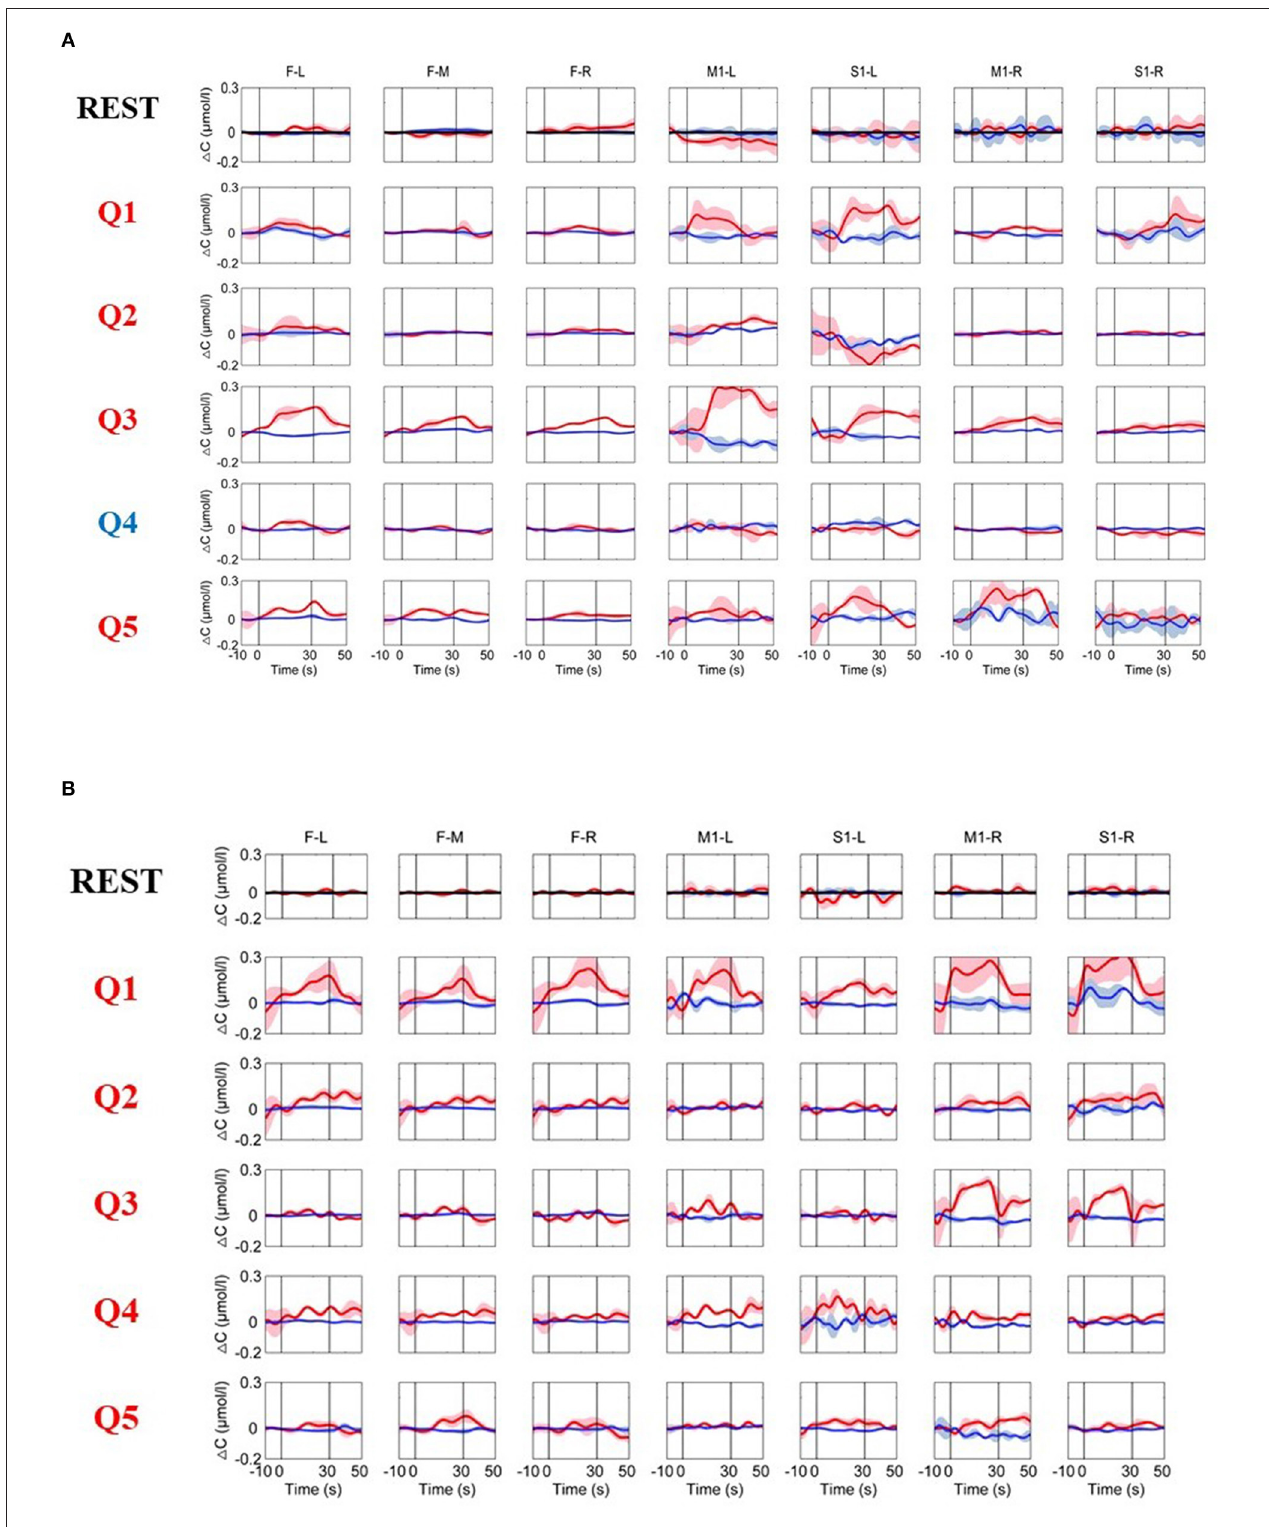
FIGURE 4 | (A) The time courses of changes in HbO and HbR concentrations averaged across all three trials from a typical MCS patient (Patient 1). (B) The time courses of the changes in HbO and HbR concentrations from Patient 5. The resting-state time course labeled “REST” refers to data acquired without MI activation and is illustrated as a reference for comparison with the question periods. Q1–Q5 represent the hemodynamic responses for different questions Q1–Q5. The red numbers represent the ground-truth “yes” questions, while the blue numbers represent the ground-truth “no” questions. The red and blue lines represent HbO and HbR, respectively. The stimulus duration is indicated by the space between the two gray